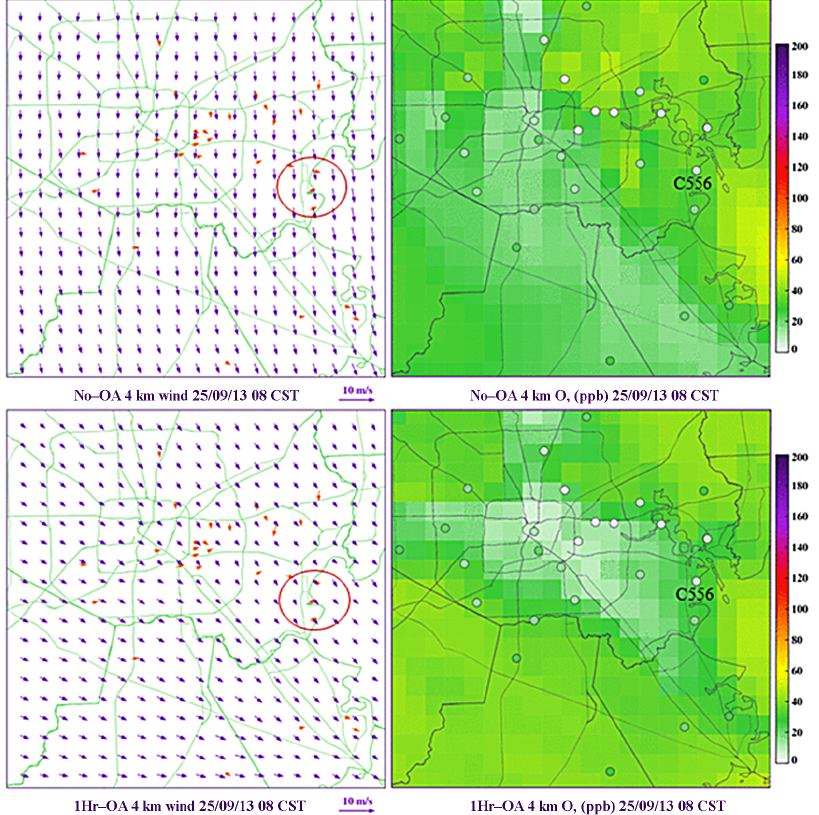
Figure 9. Zoom-in ozone concentrations (right panels) and wind plots (left panels) at 13:00CST on 25 September for No-OA (top panels) and 1Hr-OA (bottom panels). Ozone observation is in the small circle; wind observation is indicated by an orange arrow. La Porte site C556 is labeled. The numerical range of the right-side color scale is 0 to 200ppb. Higher values than 200ppb have the same color as